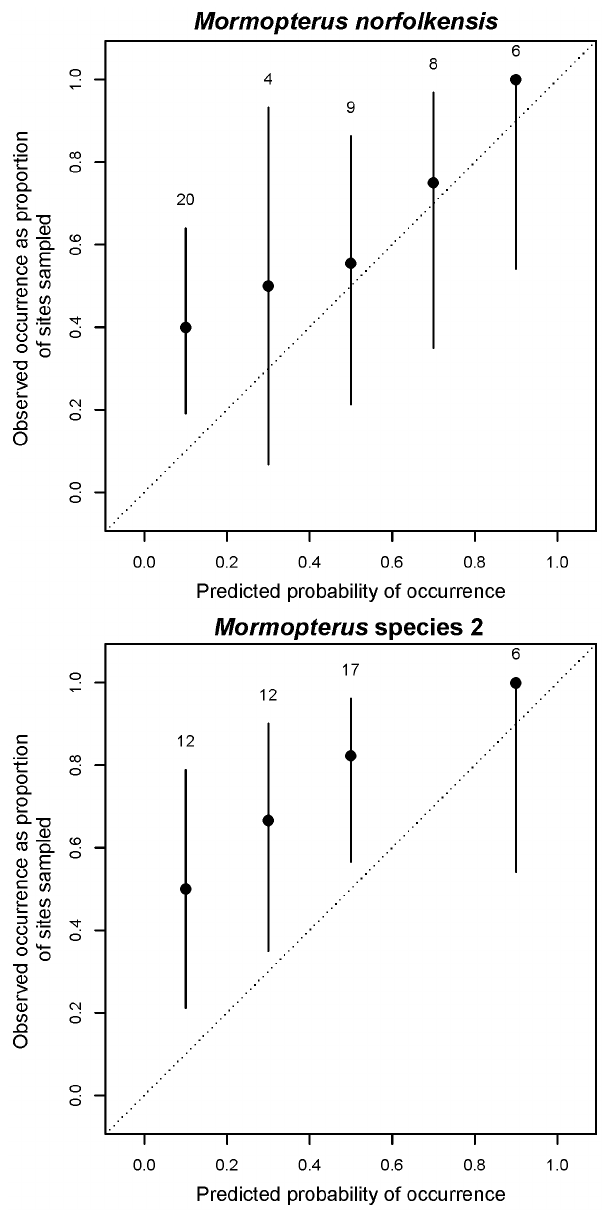
Figure 6. Spatial visualisation of prediction errors. Regional-scale probability of occurrence maps [25] presented at the local-scale of the study for Mormopterus norfolkensis and Mormopterus species 2 with activity levels from the local study overlaid. The probability of occurrence of each species from the regional-scale models was classified into three categories to aid visualisation of prediction errors. The sensitivity = specificity occurrence threshold (0.34) obtained from the local-scale study was used to define the lowest category.